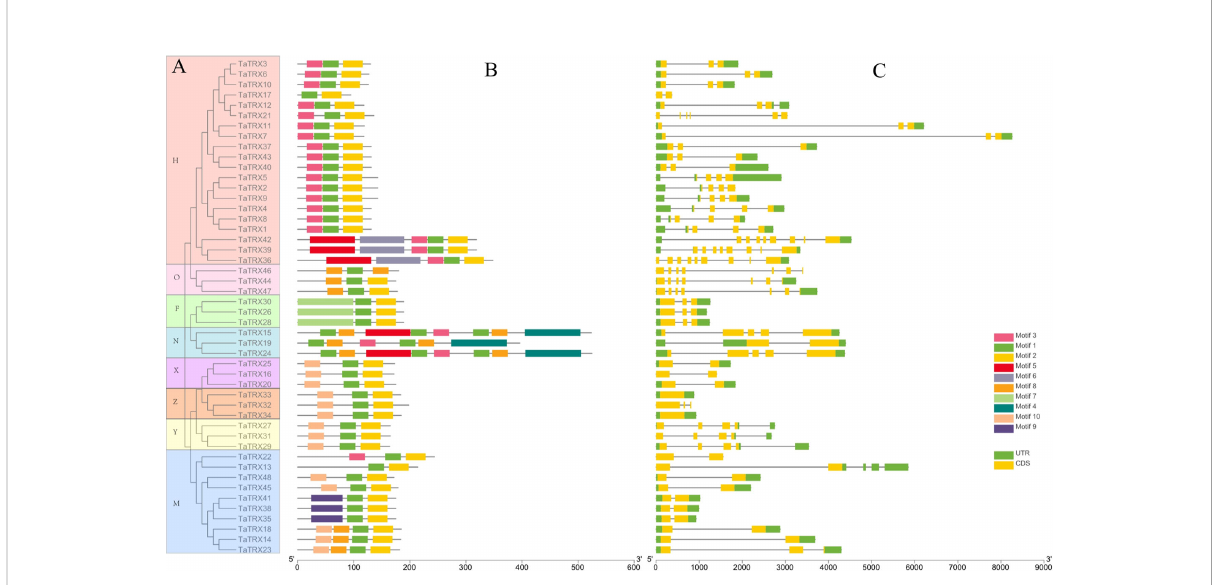
FIGURE 2 Phylogenetic relationships (A) , conserved motifs (B) , and gene structures (C) of typical TaTRX genes in wheat. The different colors in A represent the 8 subtypes of typical TaTRXs . The different colors in B represent the 10 identi fi ed motifs. The yellow and green rectangles in C represent the coding sequences (CDSs) and untranslated regions (UTRs), respectively, and the black lines represent introns. The length of the CDS, UTR, and intron for each typical TaTRX gene was shown